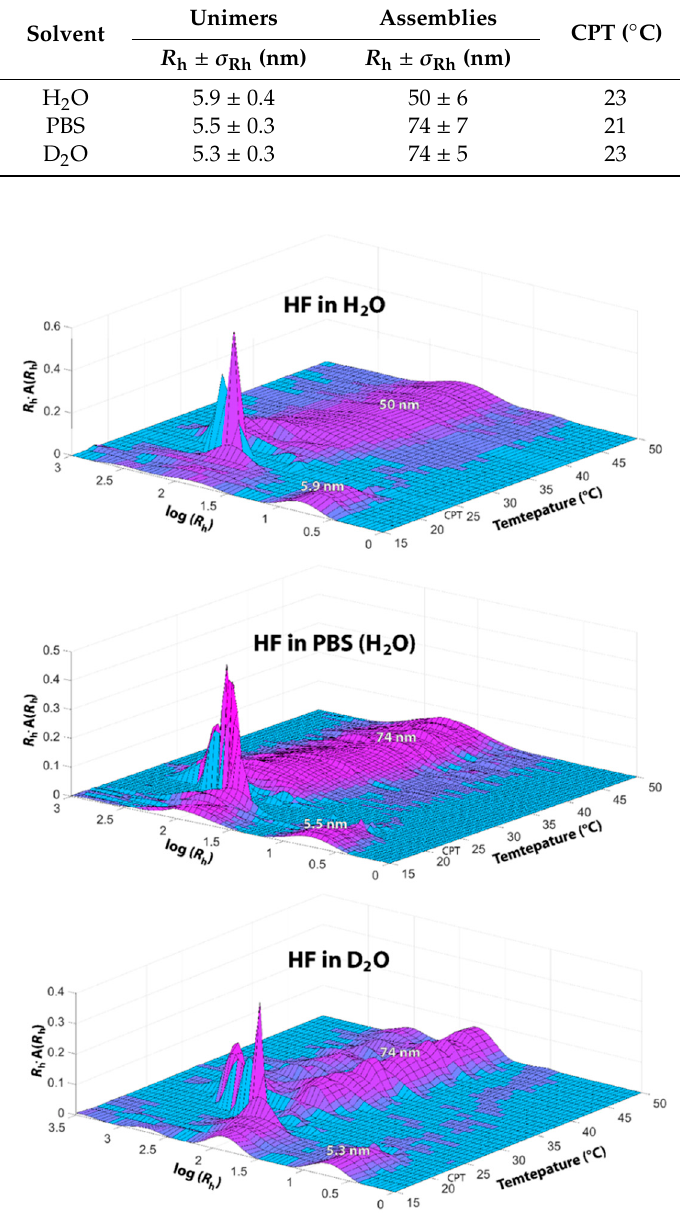
Figure 1. Temperature dependence of self-assembly of HF polymer in PBS, H 2 O and D 2 O measured by DLS. In graphs, we use equal-area representation (the vertical axis shows R h · A( R h ), where A( R h ) is the intensity distribution function of hydrodynamic radii R h of particles in the sample) to maintain legibility.